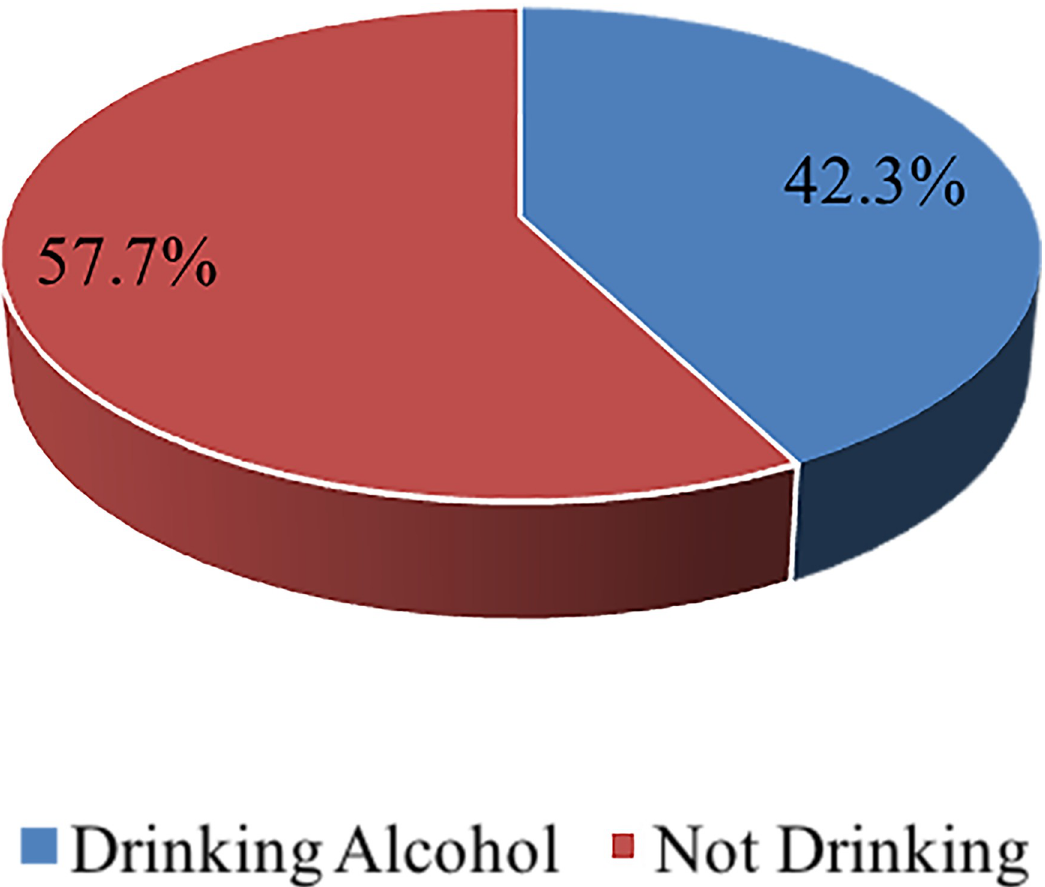
Fig 1. Prevalence of alcohol use among school going